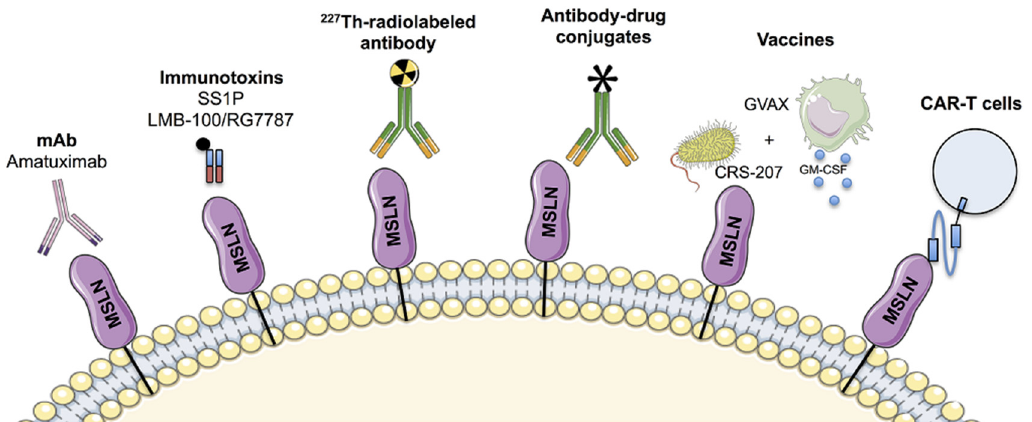
Figure 2. This schema depicts the different anti ‐ MSLN targeting drugs that are currently under clinical development, including the monoclonal antibody (mAb) amatuximab, SS1P and LMB ‐ 100/RG7787 immunotoxins, 227 Th ‐ radiolabeled antibody, antibody ‐ drug conjugates, vaccines and immunotoxins, 227 Th-radiolabeled antibody, antibody-drug conjugates, vaccines and CAR ‐ T ‐ cells.